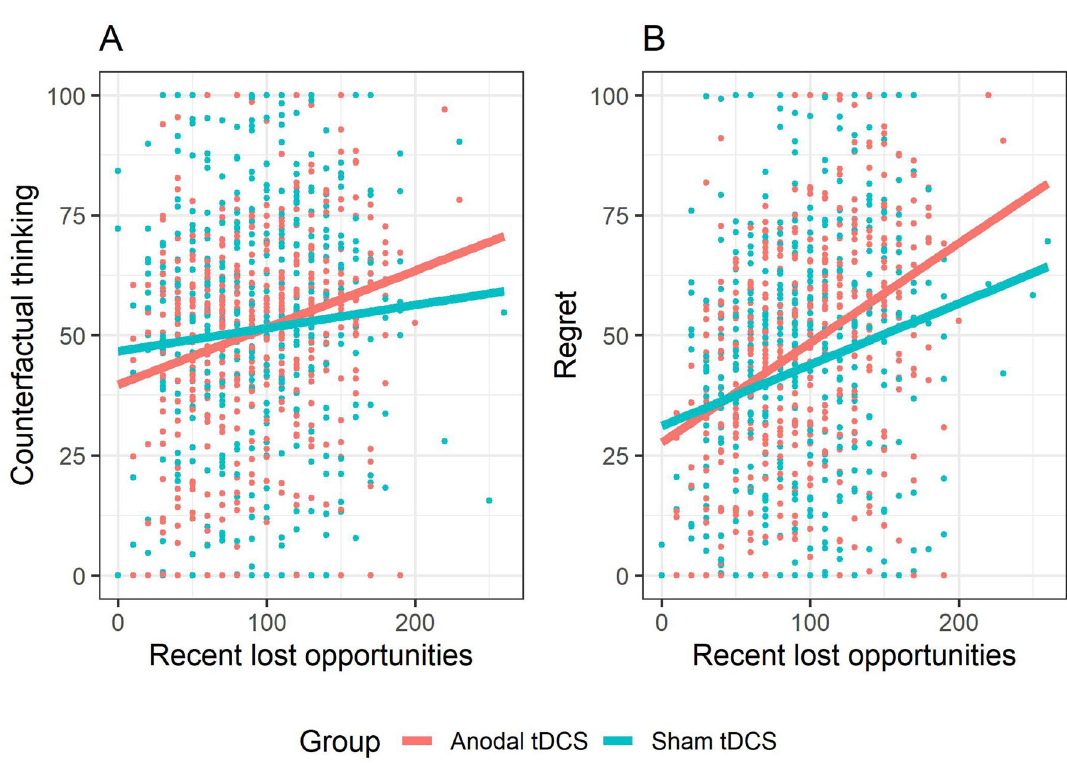
Figure 4. Role of recent lost opportunities in tDCS effects on counterfactual